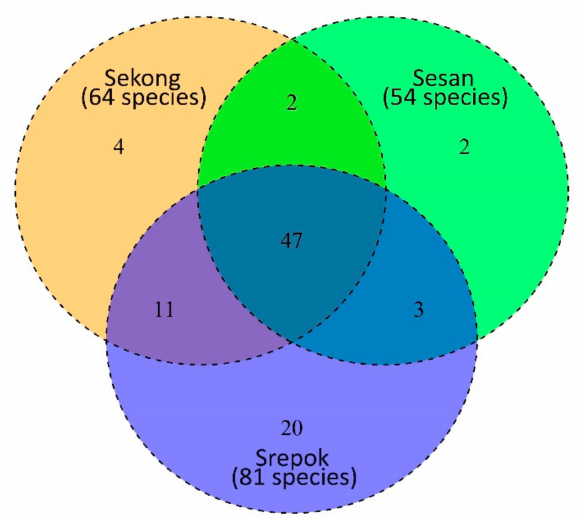
Figure 8. Overlap among the 89 migratory fish species that use 3S rivers. The number of species in brackets indicates the total number of migratory fish species that utilize each watershed. Data from